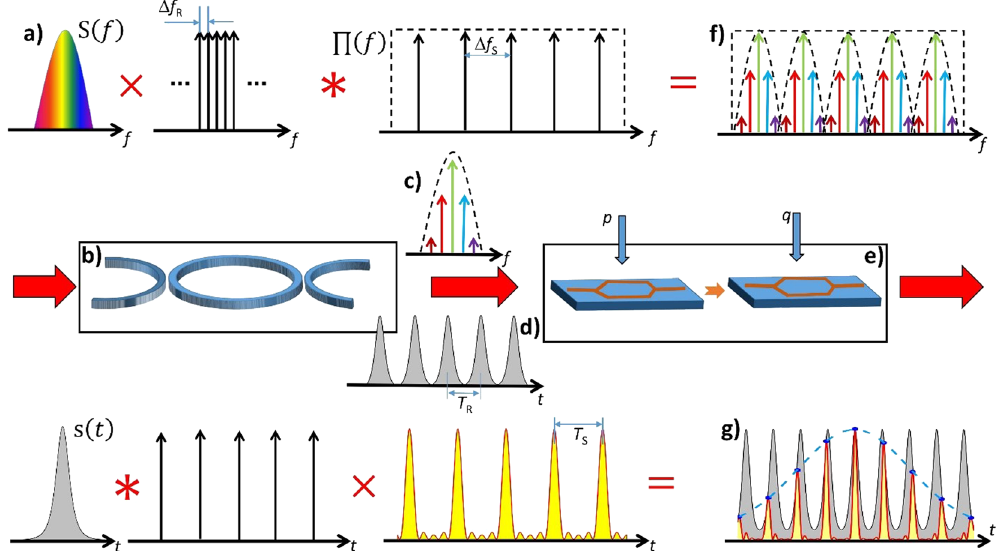
Figure 1. Basic concept of the proposed time magnifier in the frequency (top) and time domain (bottom). The multiplication between the optical input signal spectrum ( a ) with a frequency comb realized by the transfer function of a ring resonator with an infinitely high finesse ( b ) results in a convolution between the input signal and a Dirac delta comb in the time domain, or an infinite number of time copies of the input signal ( d ). In the next step, a set of two cascaded modulators ( e ) enables the convolution in the frequency domain between the discrete signal spectrum ( c ), produced by the ring resonator and a rectangular frequency comb. In the corresponding time domain, this is the multiplication of the signal copies with a sinc pulse sequence ( g ). Since the free spectral range of the ring is slightly different from the repetition rate of the sequence, the signal copies are sampled at different positions. The sampling points are the integral of the sequence over the repetition rate (blue dots) and the envelope of the sampling points gives the stretched input pulse (blue dashed